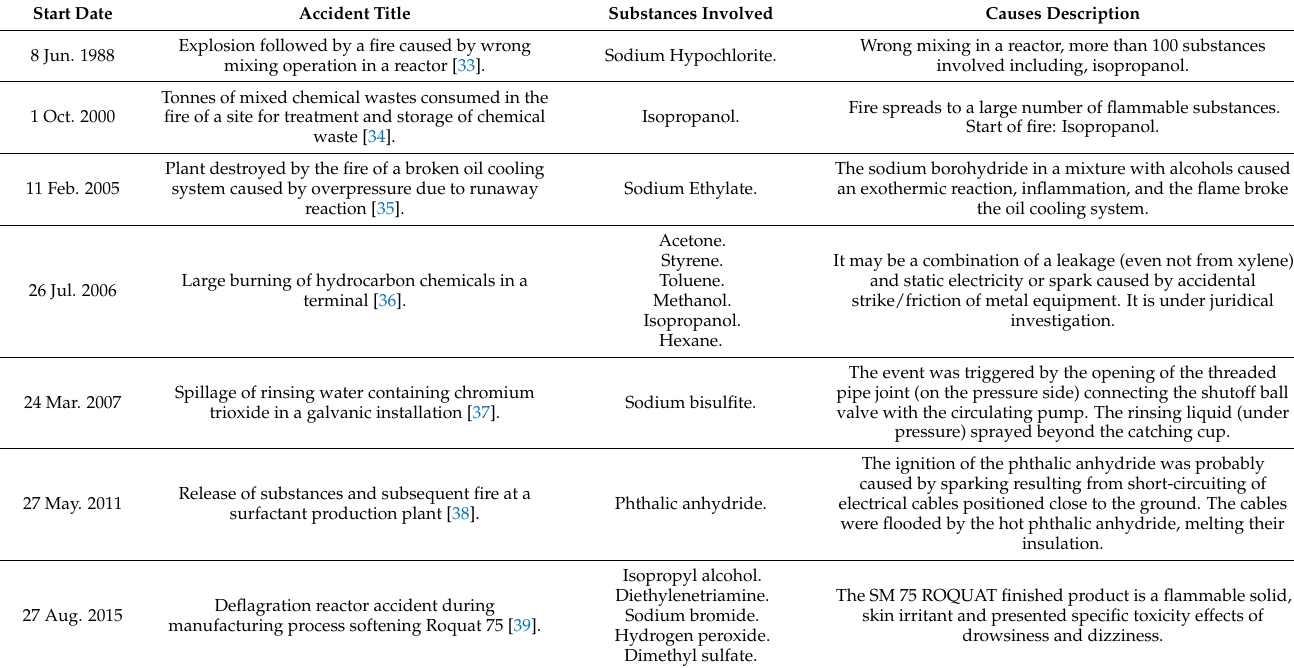
Table 1. Chemical accidents in Europe related to Isopropanol and